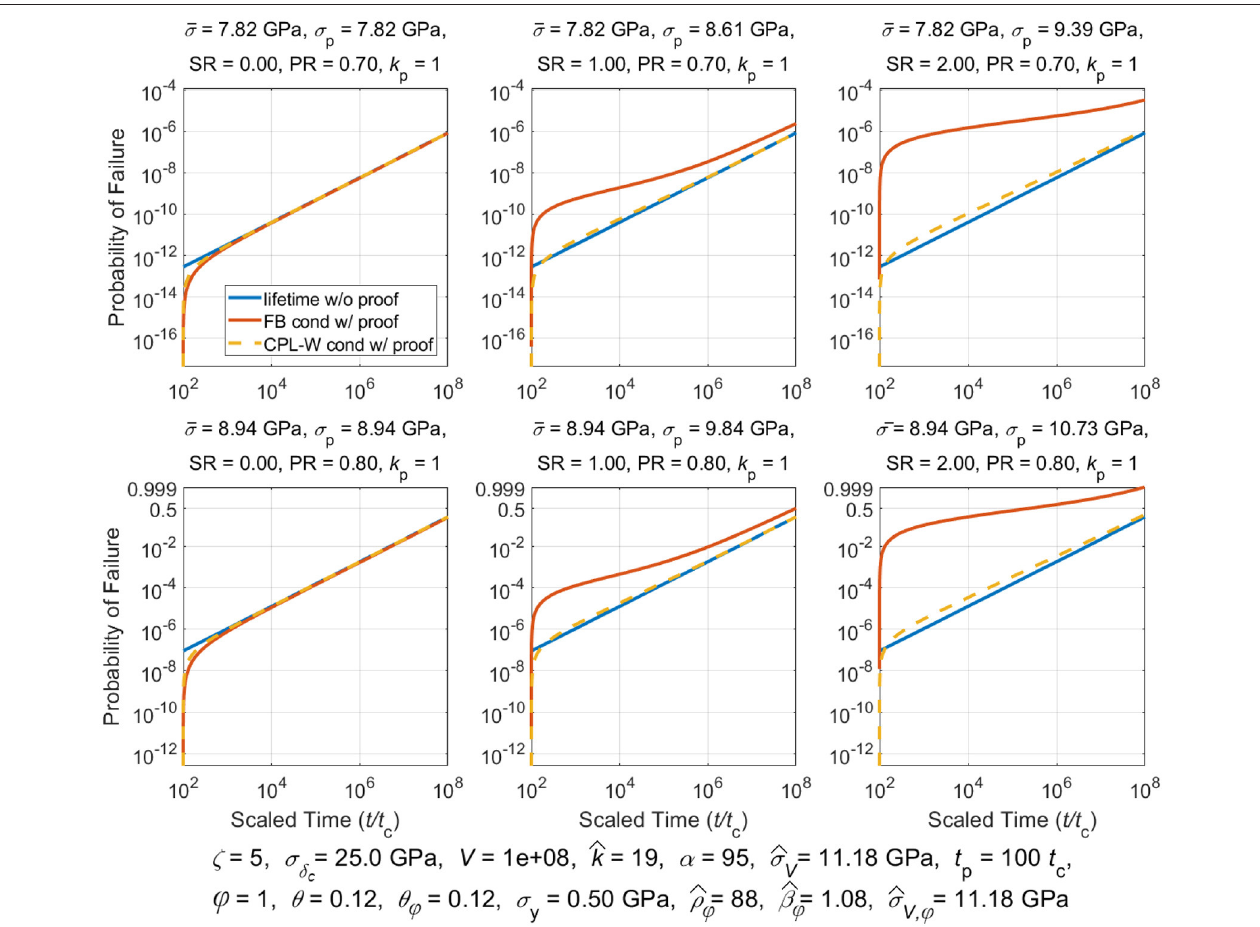
FIGURE 4 | Tows with fibers in a hexagonal array and matrix parameter, ϕ around a cluster.